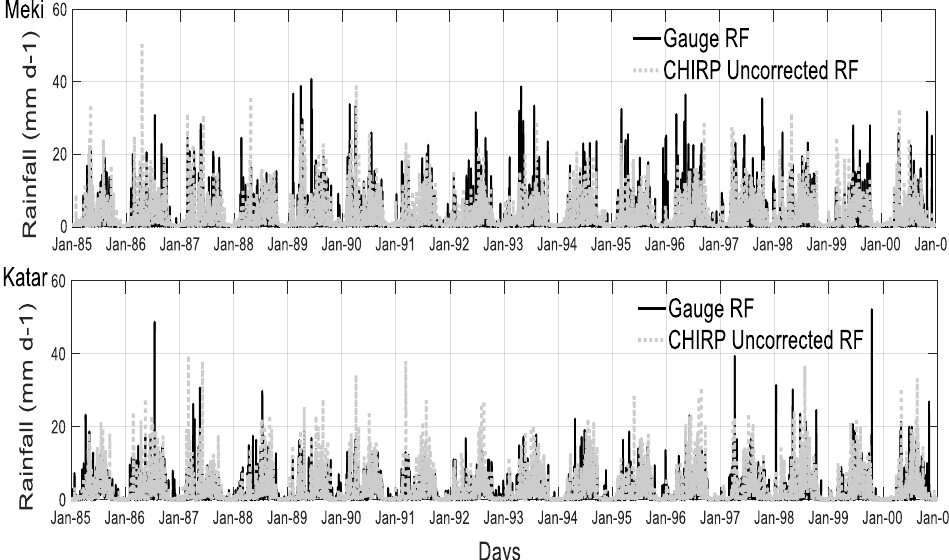
Figure 4. Comparison of daily CHIRP rainfall estimate against the gauge rainfall at Meki and Katar catchments for a time series from 1985 to 2000.